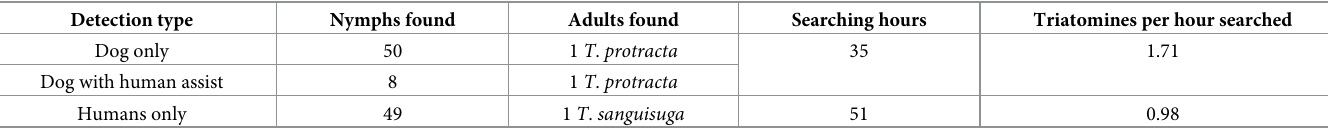
Table 1. Search success by detection type and calculation of specimens found per hours